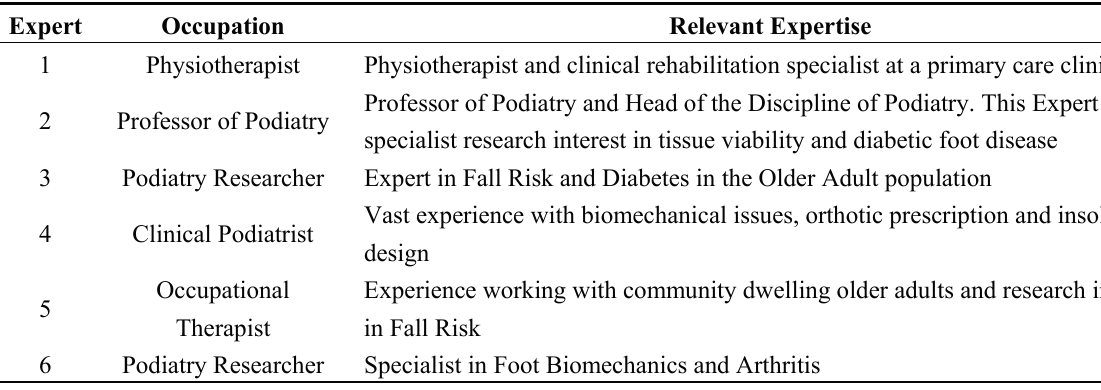
Table 1. Description of each of the experts who were recruited to carry out human factors and comfort inspection of the